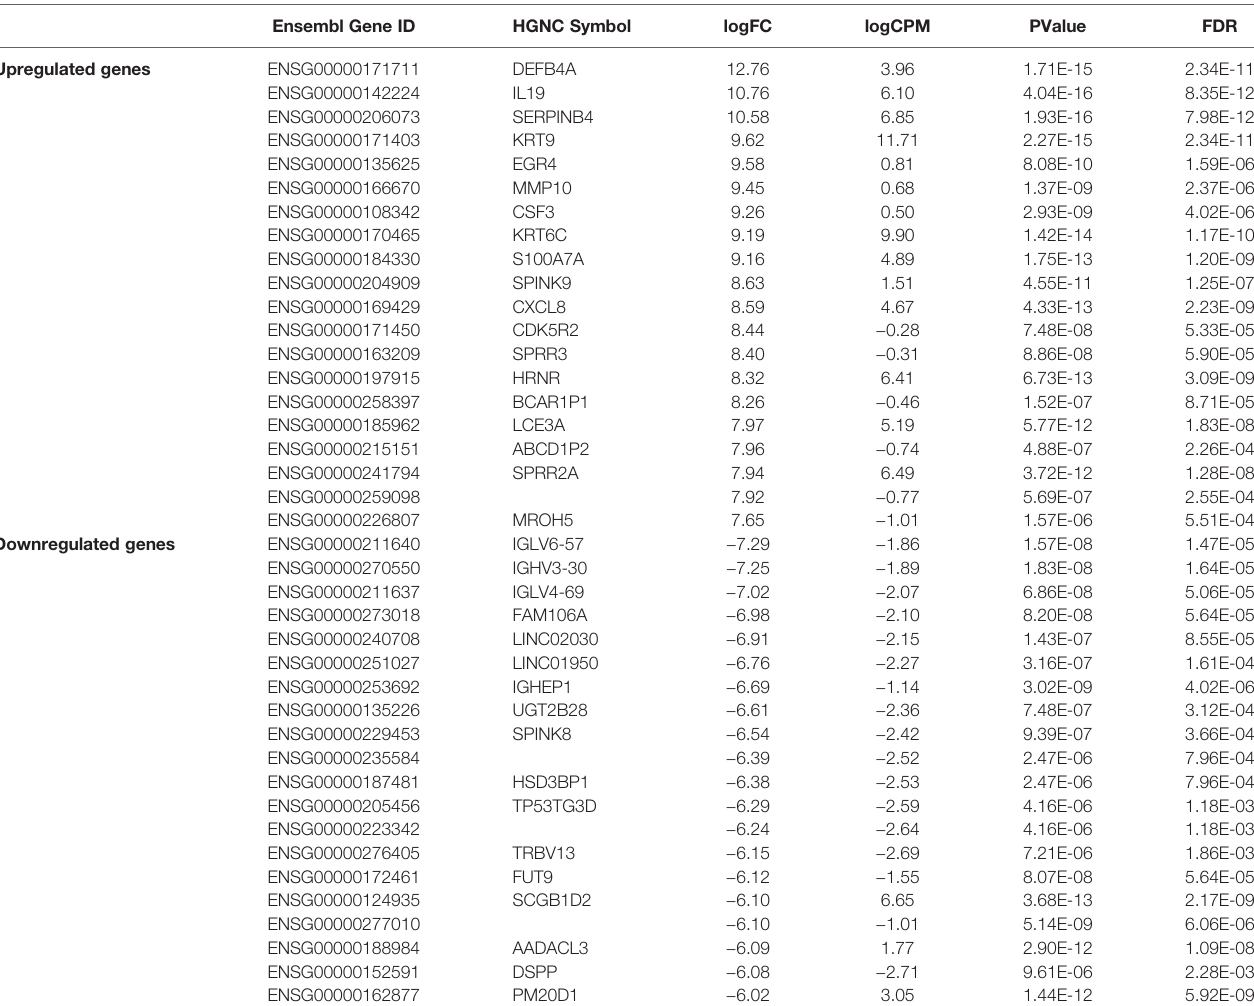
TABLE 1 | Top 20 upregulated and downregulated genes in mite-infested human skin biopsies (n=5) with respect to control samples (n = 3). Ensembl Gene ID HGNC Symbol logFC logCPM PValue FDR Upregulated genes